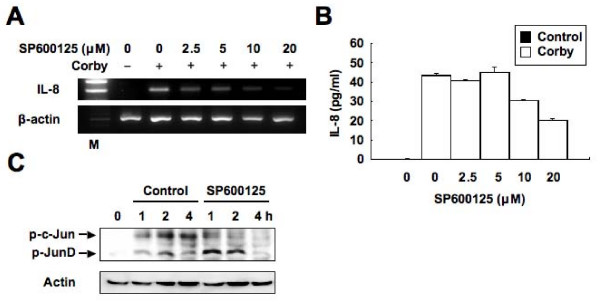
SP600125 inhibits L. pneumophila-induced IL-8 expression and secretion. Jurkat cells were pretreated with the indicated concentrations of SP600125 for 1 h prior to L. pneumophila Corby infection and subsequently infected with Corby (MOI, 100:1) for 4 h (A) and 24 h (B). IL-8 mRNA expression on harvested cells was analyzed by RT-PCR (A) and the supernatants were subjected to ELISA to determine IL-8 secretion (B). Data are mean ± SD of three experiments. (C) Jurkat cells were pretreated with or without SP600125 (20 μM) for 1 h prior to L. pneumophila Corby infection and subsequently infected with Corby (MOI, 100:1) for the indicated times. Cell lysates were prepared and subjected to immunoblotting with the indicated antibodies. Data in (A) and (C) are representative examples of three independent experiments with similar results.